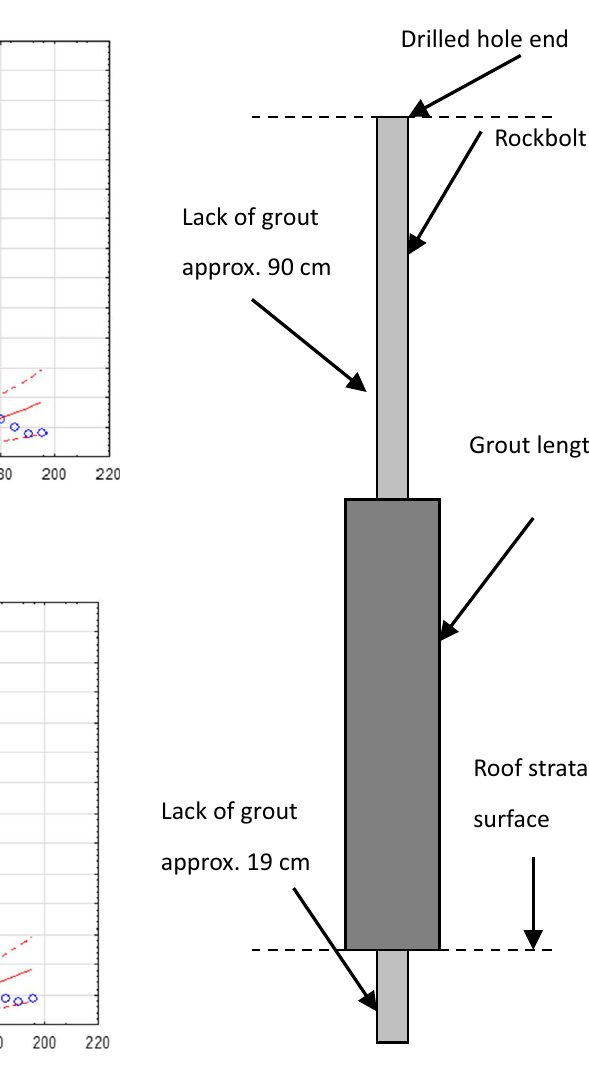
with the working prototype, the lower one b For measurements with the final version of the measurement unit. The discontinuity lengths are: 90 cm (inner part) and 19 cm (outer part, scatter plot not shown